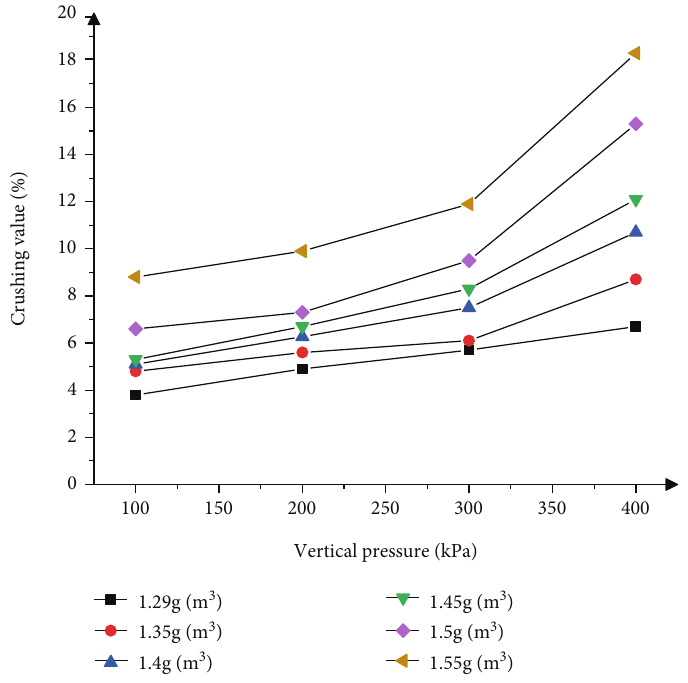
Figure 6: Curve of relationship between crushing value and vertical pressure.